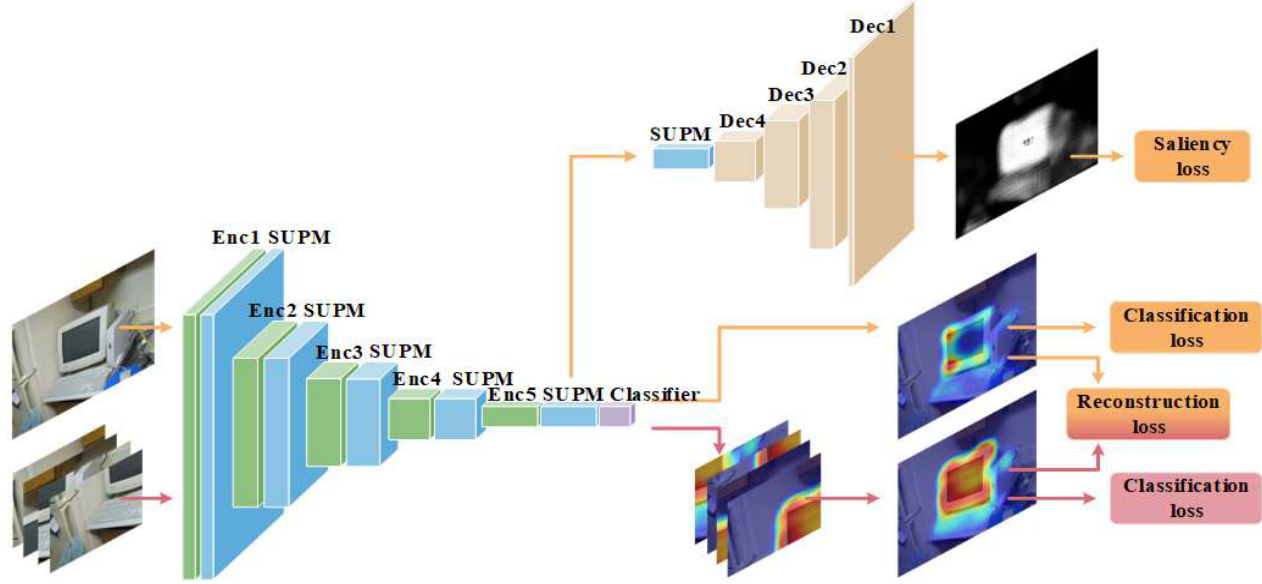
Figure 1. Proposed suppression module and saliency map guided module.